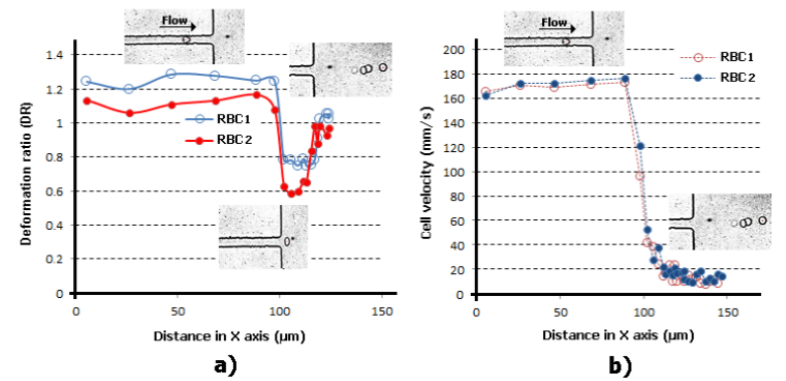
Figure 10. Individual RBCs’ ( a ) DR and ( b ) velocity flowing through a rectangular PDMS microcapillary for the same flow rate. The X axis corresponds to the main flow